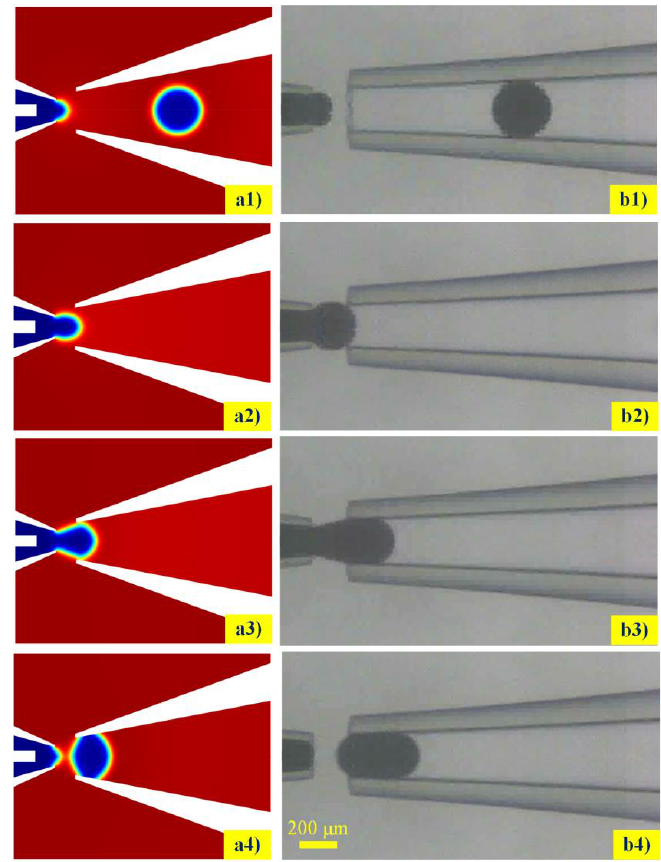
Figure 4. Comparison of liquid metal microdroplets detachment form the capillary tip between simulated ( a1 – a4 ) and experimental ( b1 – b4 ) observation during the droplet formations.